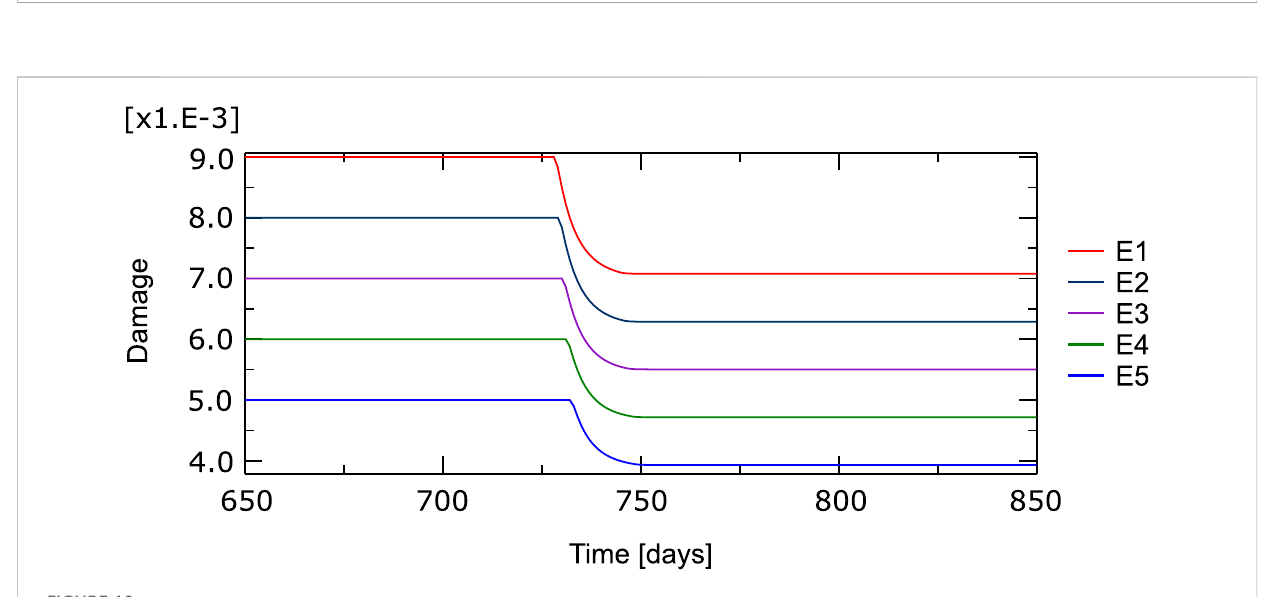
FIGURE 10 Temporalevolution ofthedamagevariable inthe fi veelements withahighlevel ofinitial damage (E1to E5,see Figure 9).Aroundday730 theBMUis activated, fi rst in the most damaged element, and advance through these particular elements partially repairing the tissue through